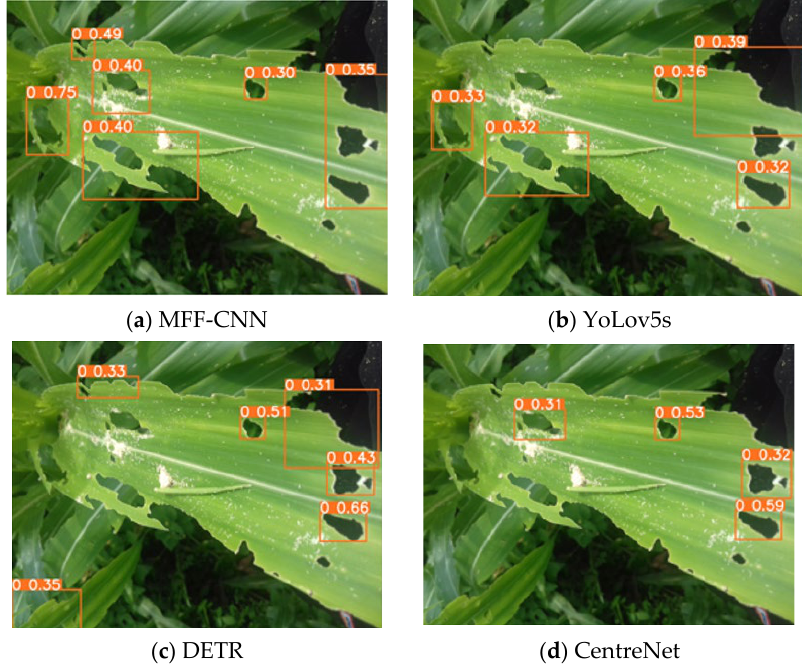
Figure 11. Detection results of the sparse distribution of diseased leaves.